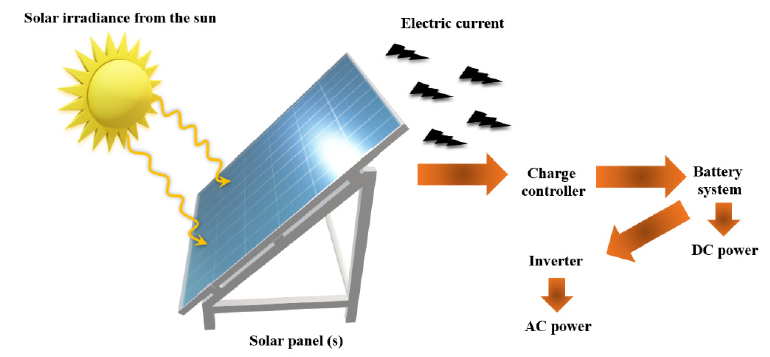
Figure 9. Classic solar cell structure and current production.